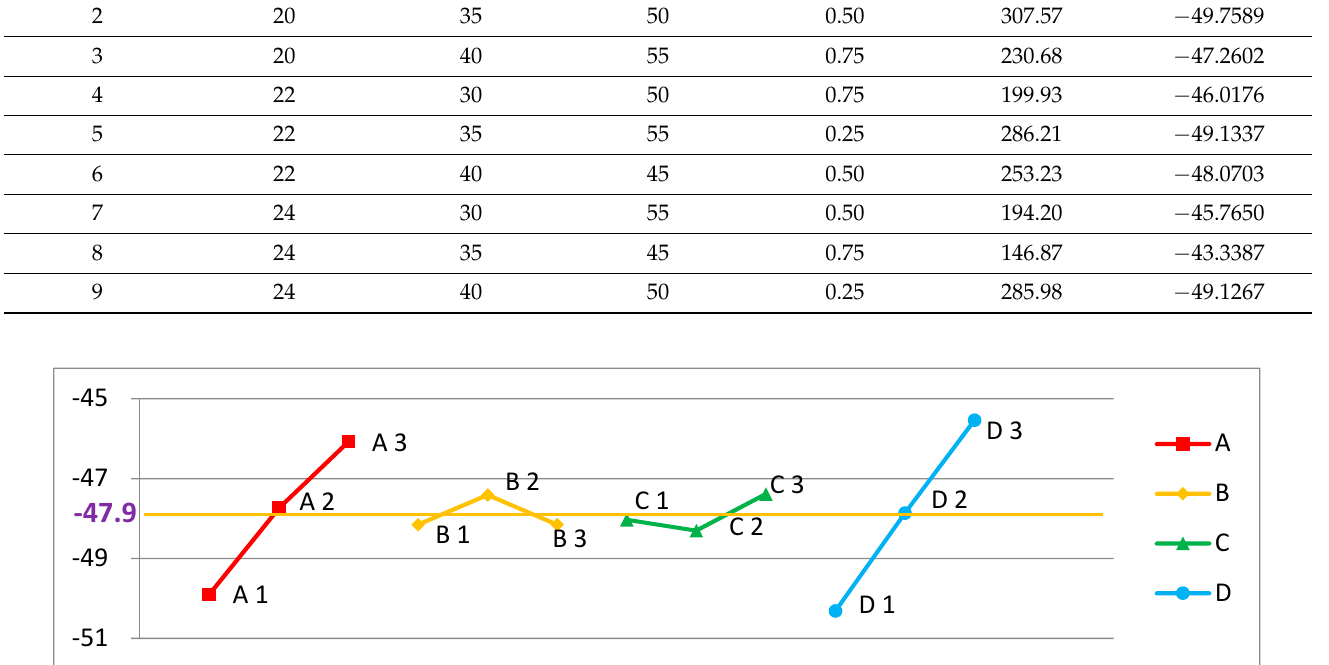
Figure 6. Factor S/N ratio of the new spanner.